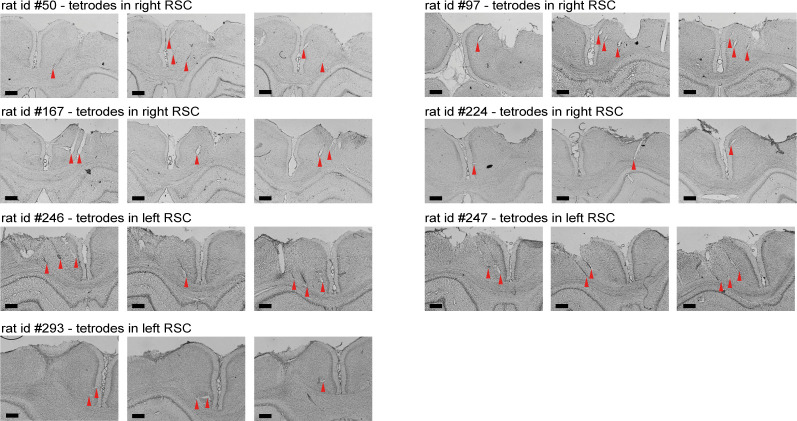
Nissl-stained coronal sections showing recording locations and tetrode tracts for all recording experiments.Shown are three coronal sections for each of the seven animals included in the electrophysiological experiments. The top two rows include four rats (rats #50, #97, #167, and #224) with the electrode implanted in the right hemisphere, and the bottom rows show sections of three rats with a drive in the left hemisphere (rats #246, #247, and #293). Recordings started at approximately 1 mm below the surface of the cortex and continued in a medioventral direction with a 25° angle until tetrodes reached either the midline or corpus callosum. Red triangles indicate the end of tetrode tracts. Scale bars, 500 μm.